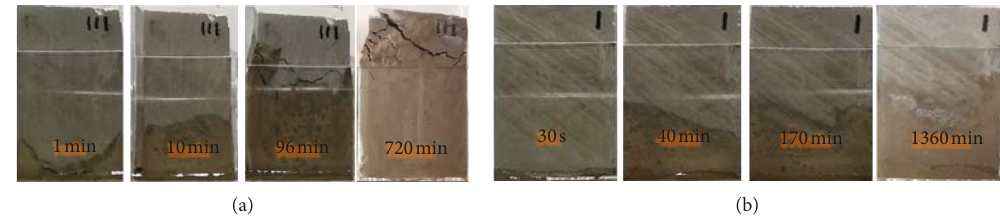
Figure 9: Images of spontaneous imbibition from the bottom. (a) 3# sample is under free restraints. (b) 1# sample is under lateral restraints.